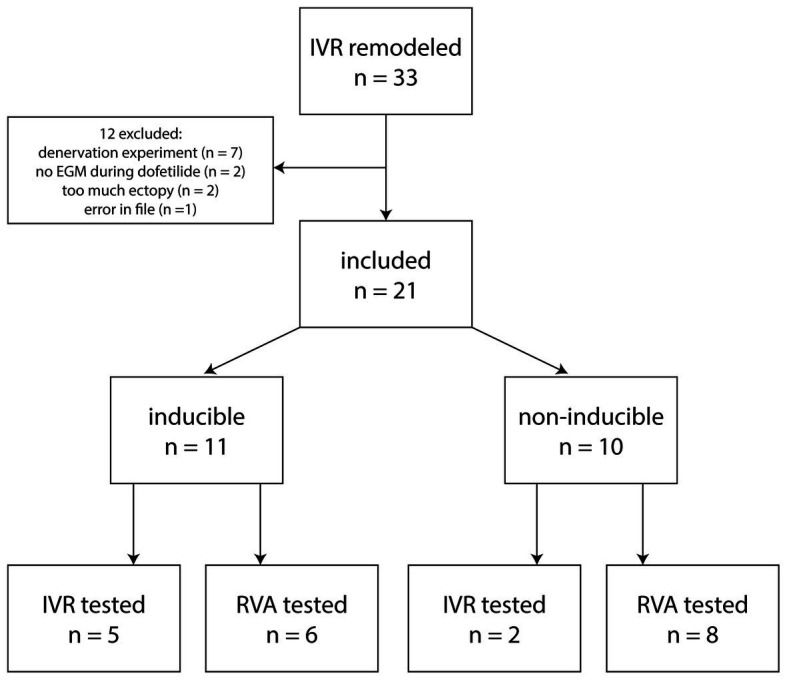
Flowchart of dogs included in part 2.